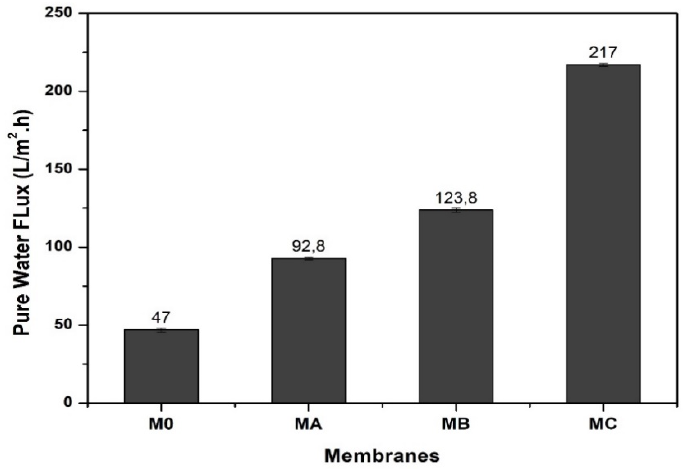
Figure 8. E ff ects of dopamine loading on the pure water Figure 8. Effects of dopamine loading on the pure water flux.